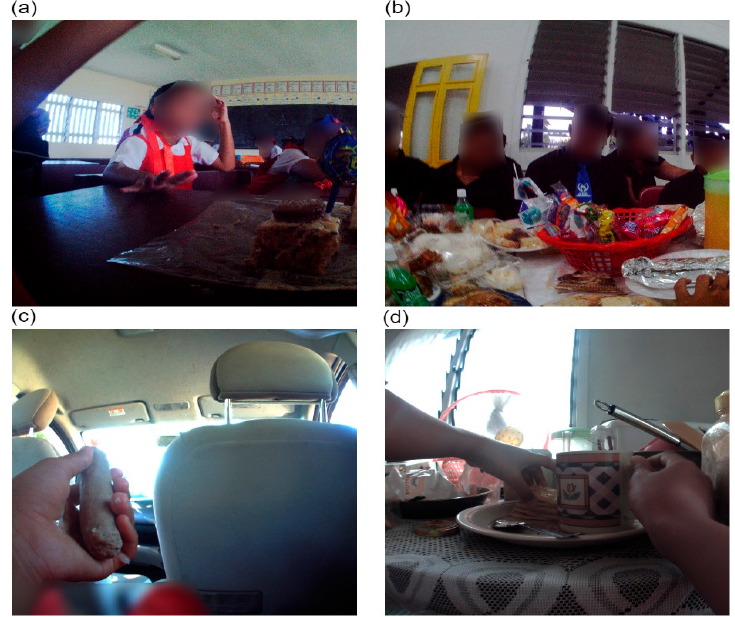
Figure 3. Food consumption by setting ( a ) school, ( b ) church/church hall, ( c ) private transport, and ( d ) home